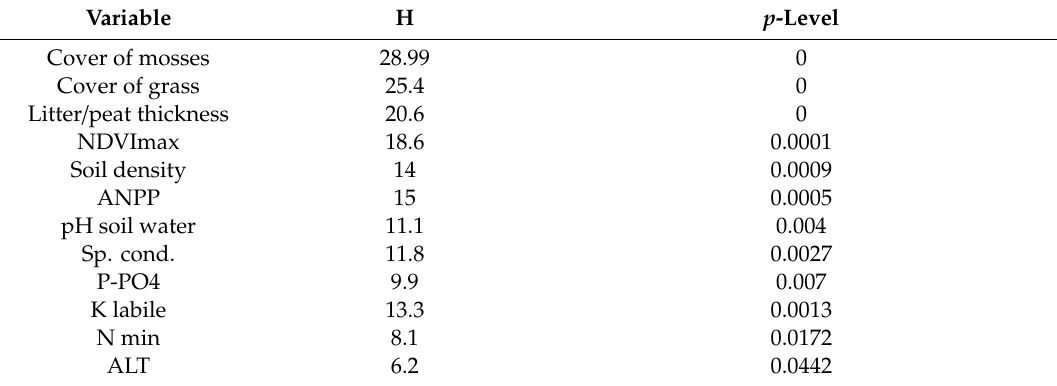
Table A3. Compilation of statistical parameters for the di ff erences in litter / peat thickness, NDVImax, oil density, ANP, pH soil water, sp. cond., P-PO4, K labile, ALT, N min among successional stages of the khasyreys.